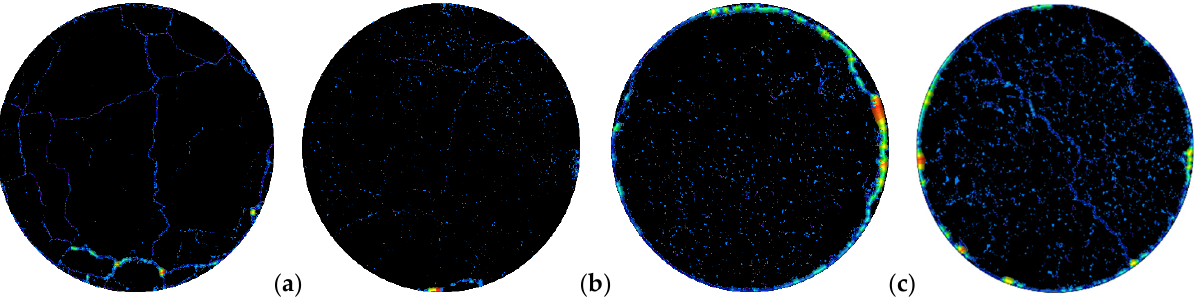
Figure 14. Cracks in soil sample after 8 WD cycles: ( a ) 0.25 mm; ( b ) 0.50 mm; ( c ) 2.00 mm; ( d ) 5.00 mm.